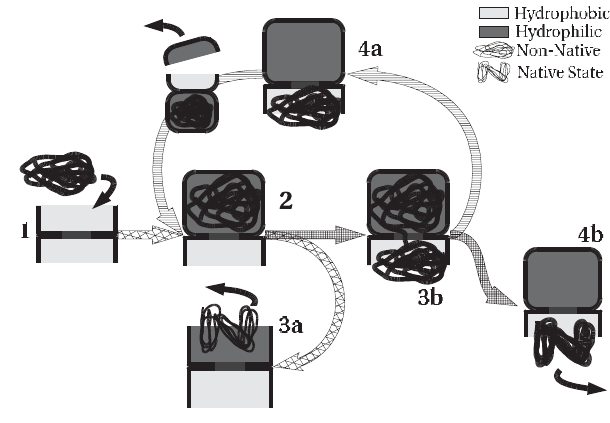
Figure 2. The present simulations suggest that non-native proteins may reach their native state either by the standard ‘‘intra-chamber’’ folding or by translocation through the equatorial region. The two pathways are shown in the schematic drawing above. In the initial configuration (1), the chaperonin barrel is open and exposes a hydrophobic rim for binding partially